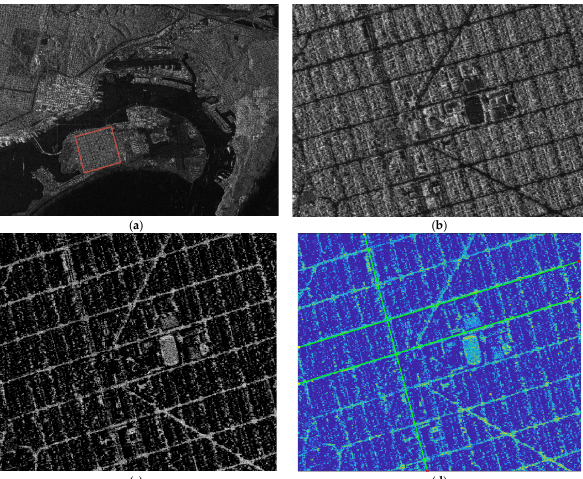
Figure 12. Extraction results of GF-3-based hyper-pixel geometric orientation in San Diego. ( a ) The SAR image of this scene at central location of (LON 117°14 ′ 49.7113 ″ W, LAT 32°42 ′ 18.7956 ″ N). ( b ) The target residential area on the small island in the scenario, corresponding to the area in the red box in ( a ). ( c ) Normalized pixel interval and grayscale inverted image. ( d ): The straight lines of the roads in the scenario obtained by standard Hough transform.